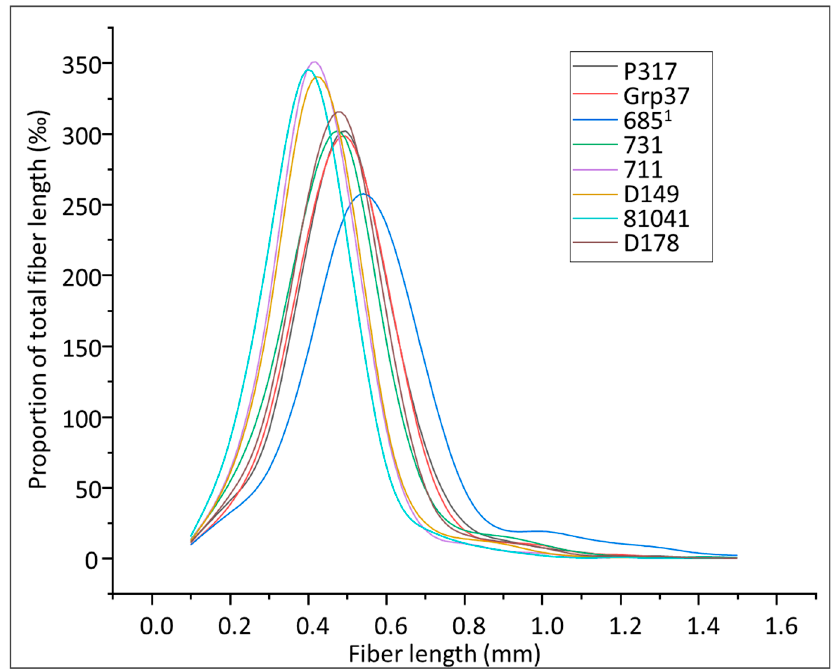
Figure 5. Statistical results of S. viminalis clone fiber analysis. 685 1 : clone from block 1.